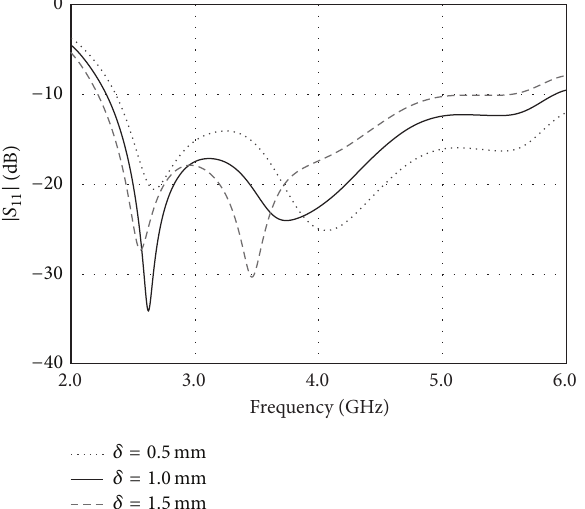
Figure 7: |𝑆 11 | relative to frequency as a function of 𝛿 .